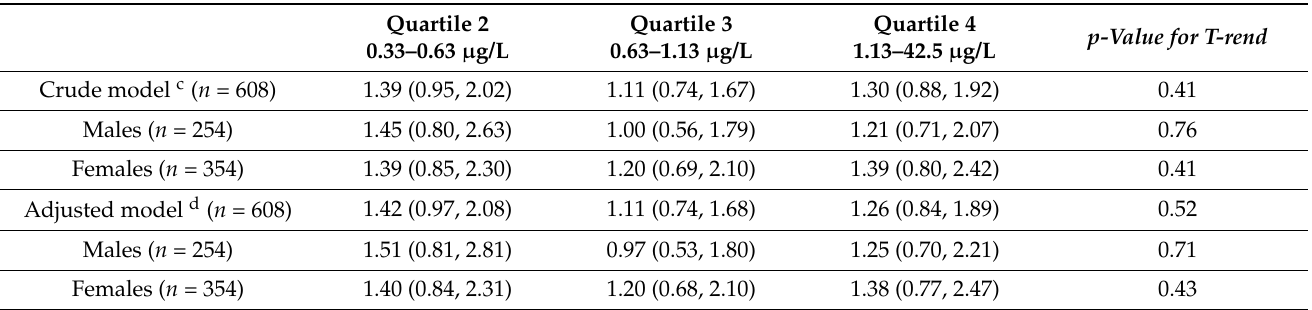
Table 2. Sub-distribution hazard ratios and 95% confidence intervals for the longitudinal associations a between quartiles of manganese and metabolic syndrome ( n = 608) b .